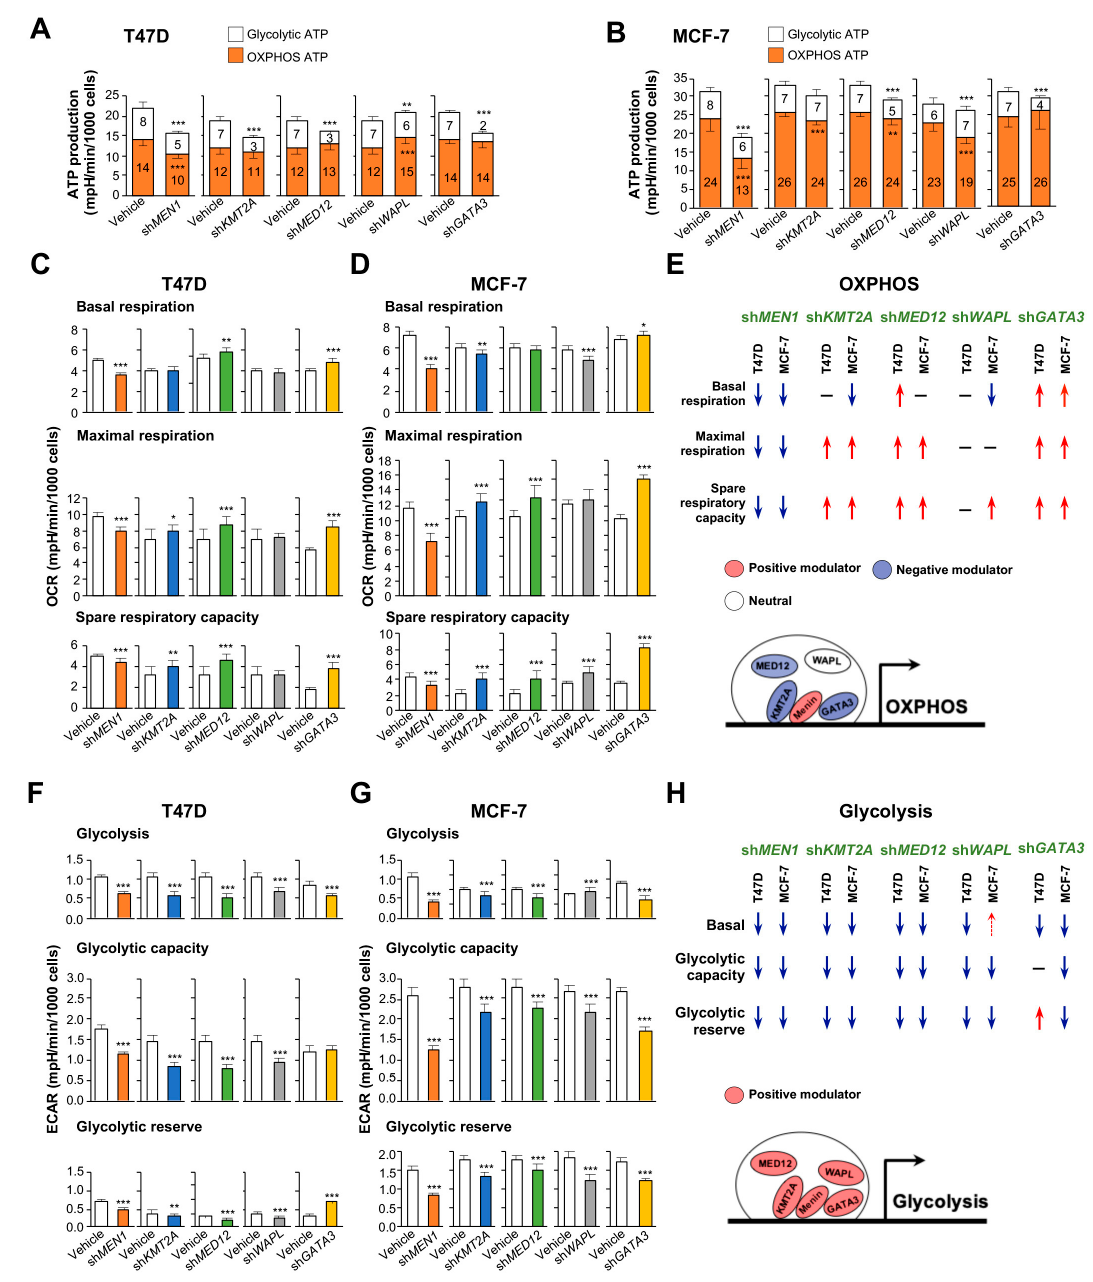
Figure 4. Bioenergetic dynamics are regulated by menin and MAPs in T47D and MCF-7 cells. ( A ) and ( B ) Glycolytic and OXPHOS ATP productions in T47D ( A ) or MCF-7 ( B ) cells infected with vehicle, sh MEN1 , sh KMT2A , sh MED12 , sh WAPL , or sh GATA3 lentivirus. Statistics represented the difference of glycolytic or OXPHOS ATP production between shRNA knockdown and vehicle controls. ( C ) and ( D ) Bar charts representing mitochondrial functions in the single knockdown of MEN1 , KMT2A , MED12 , WAPL , or GATA3 and their vehicle control in T47D ( C ) or MCF-7 ( D ) cells. ( E ) Schematic summary of mitochondrial dynamics affected by the knockdown of MEN1 or MAPs. ( F , G ) Bar charts represented the glycolytic functions in T47D ( F ) or MCF-7 ( G ) cells subject to gene knockdown by sh MEN1 , sh KMT2A , sh MED12 , sh WAPL , or sh GATA3 lentivirus. ( H ) Schematic summary of glycolytic functions affected by the knockdown of MEN1 or MAPs. Data are presented as mean ± S.D. ( n = 15–20 technical-replicate wells). Statistical significance was performed by an unpaired two-tailed Student’s t -test between treated groups and corresponding controls. * p < 0.05, ** p < 0.01, and *** p < 0.001.